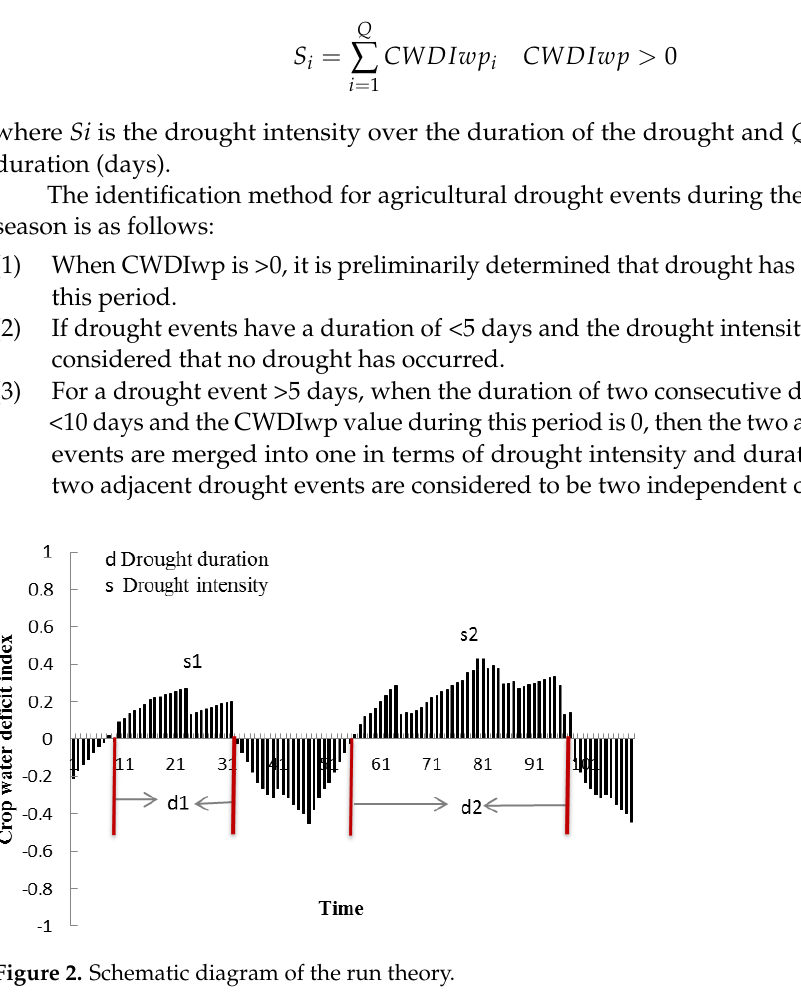
Table 1. Threshold indicator of agricultural drought